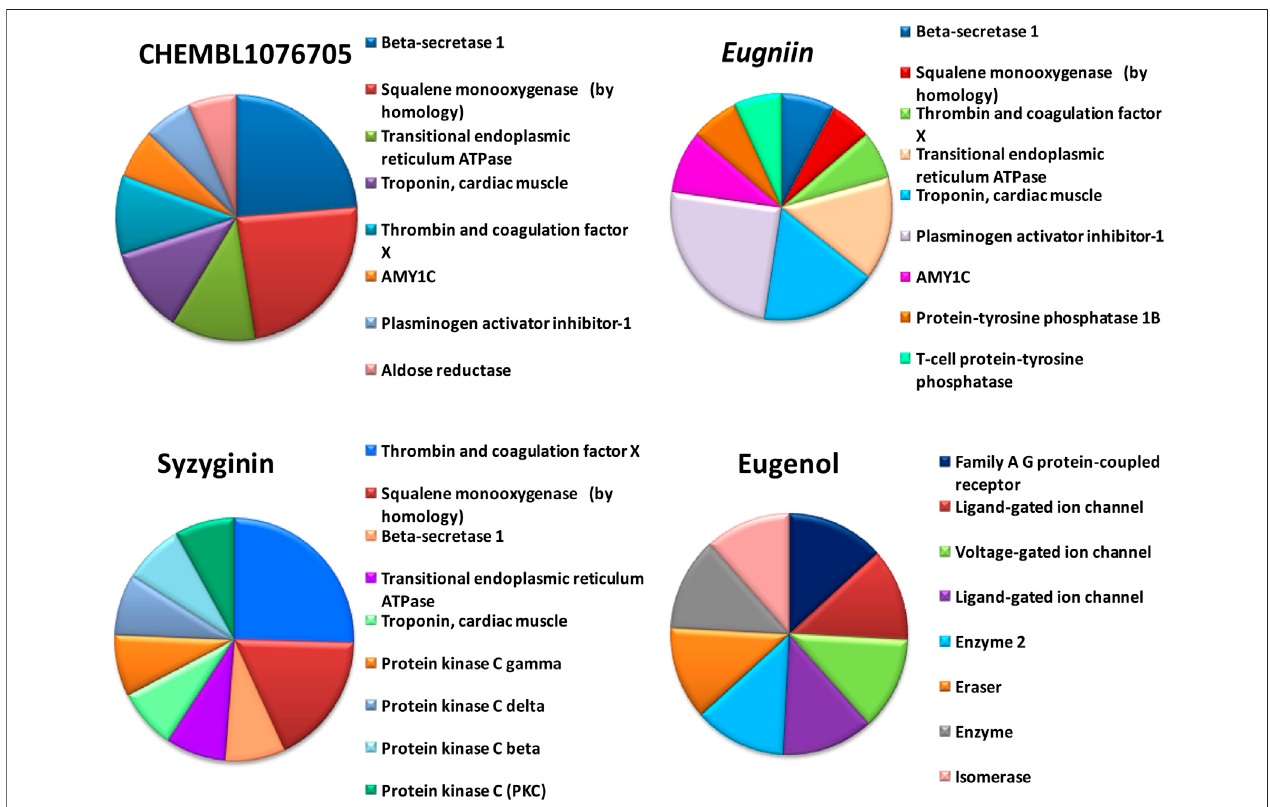
FIGURE 4 | Off-target prediction of selected compounds including beta secretase, squalene mono-oxygenase, thrombin, and coagulation factor.